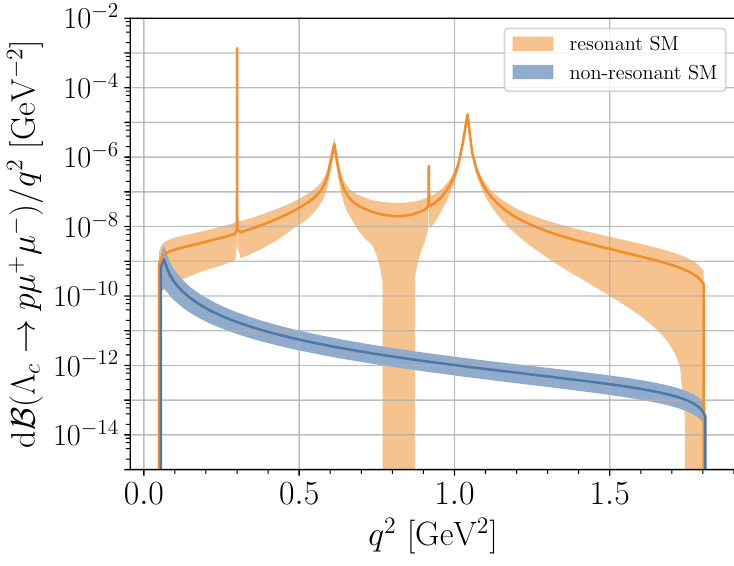
Figure 1 . The differential SM branching fraction of Λ c → pµ + µ − . In blue (orange) the short- distance (pure resonant) contributions are shown. Their widths indicate theoretical uncertainties of hadronic form factors, resonance parameters and scale uncertainty µ resonant case is obtained by averaging after varying strong